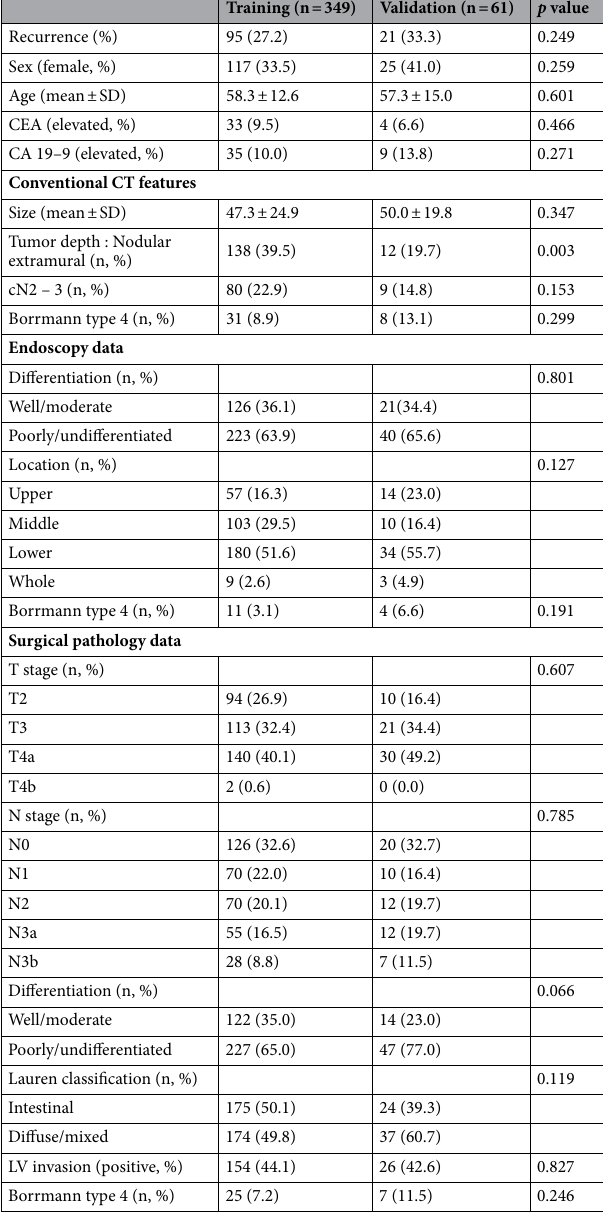
Table 1. Patient characteristics in the training and validation cohorts. SD, standard deviation; CEA, carcinoembryonic antigen; CA, carbohydrate antigen; LV invasion, lympho-vascular